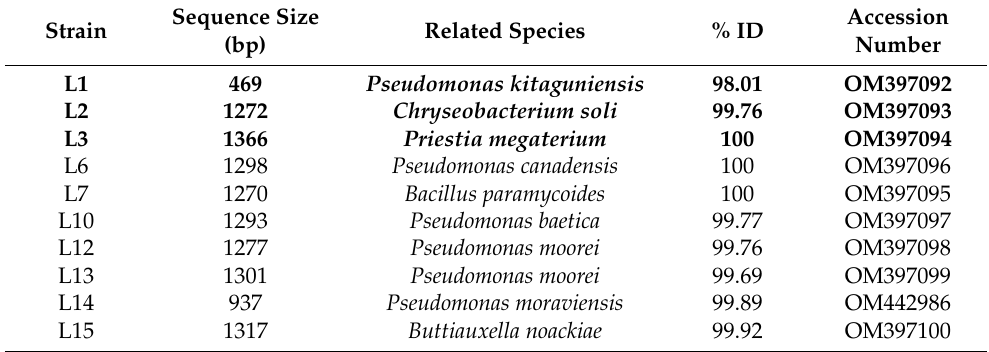
Table 2. Identification of cultivable bacteria isolated from the rhizosphere of Medicago spp. Using the EzBiocloud database. Selected strains appear in bold.